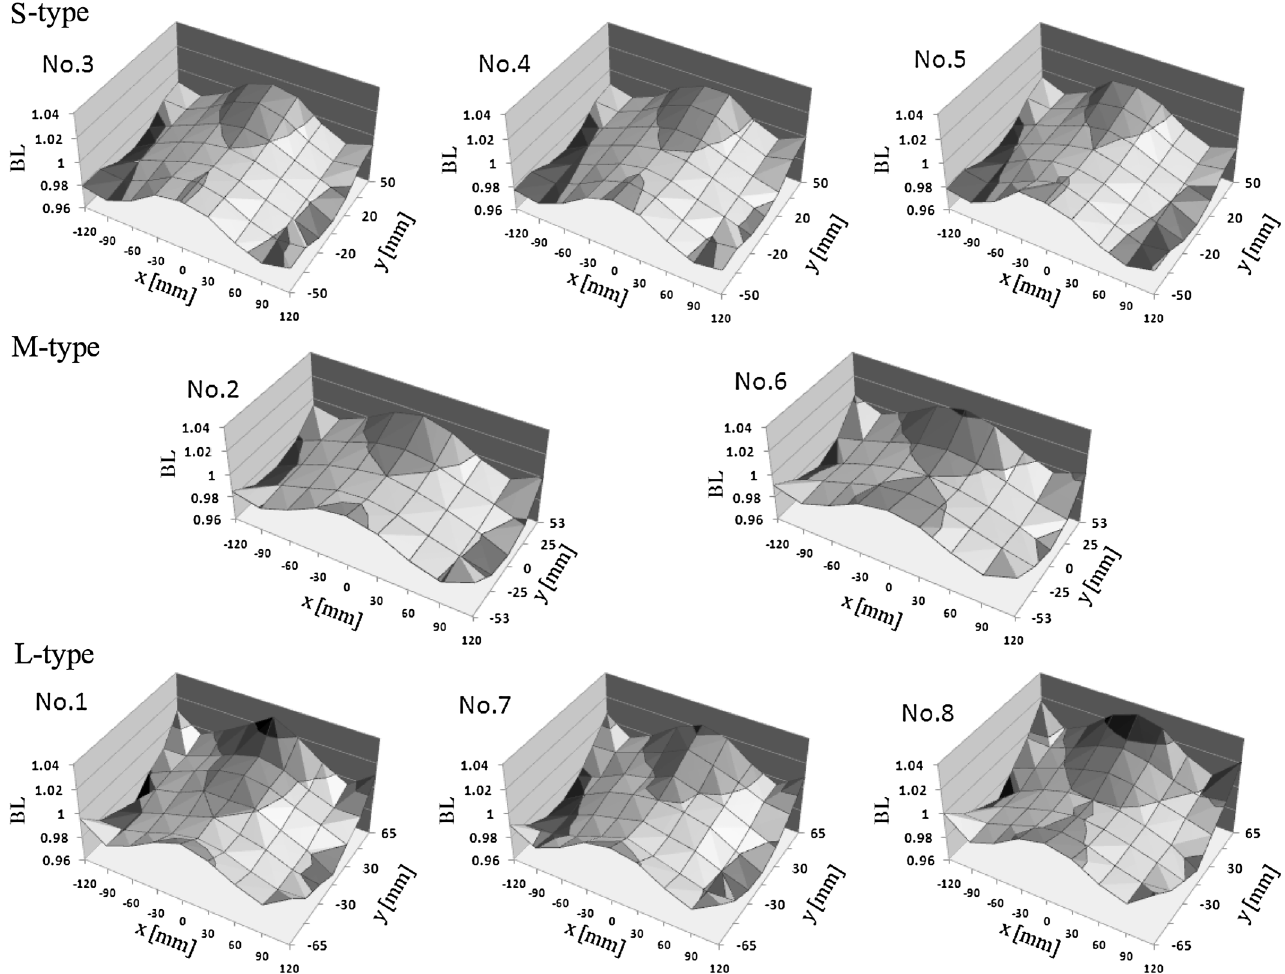
FIG. 6. The contour maps of the integrated magnetic field distribution. The definition of each axis and magnet number is the same as that of Fig. 5.